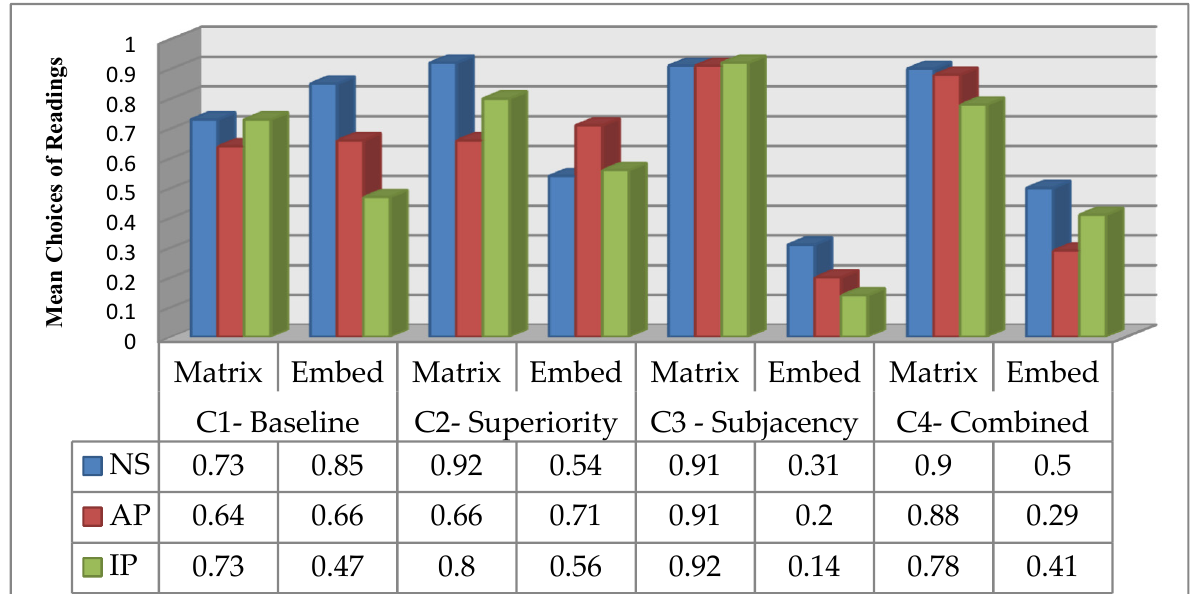
Figure 1. Mean matrix and embedded (Embed) interpretations of the higher wh-phrase for all three participant groups in the TVJ task: NS (Native), AP (L2 Advanced Proficiency), and IP (L2 Intermediate Proficiency .